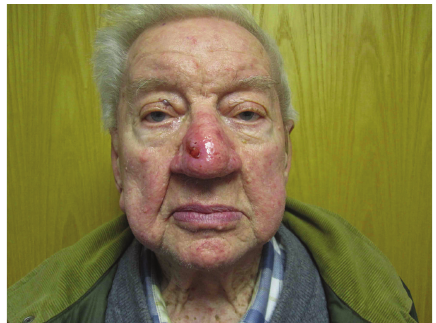
Figure 11: Case 3, three week postoperative frontal.